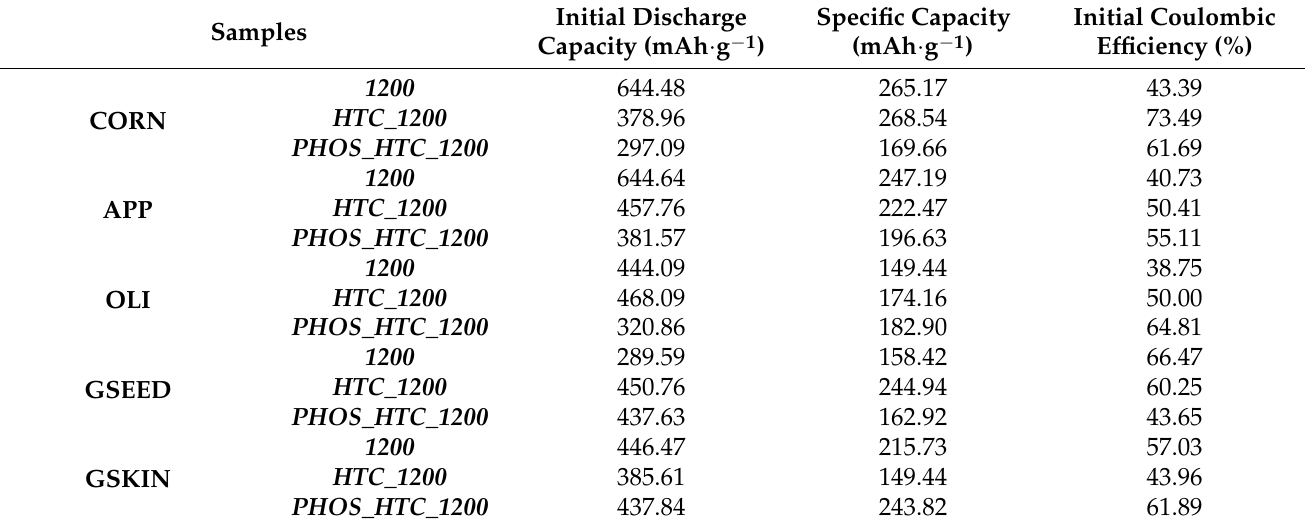
Table 4. Electrochemical performances in each sample at C/15 (24.8 mA · g − 1